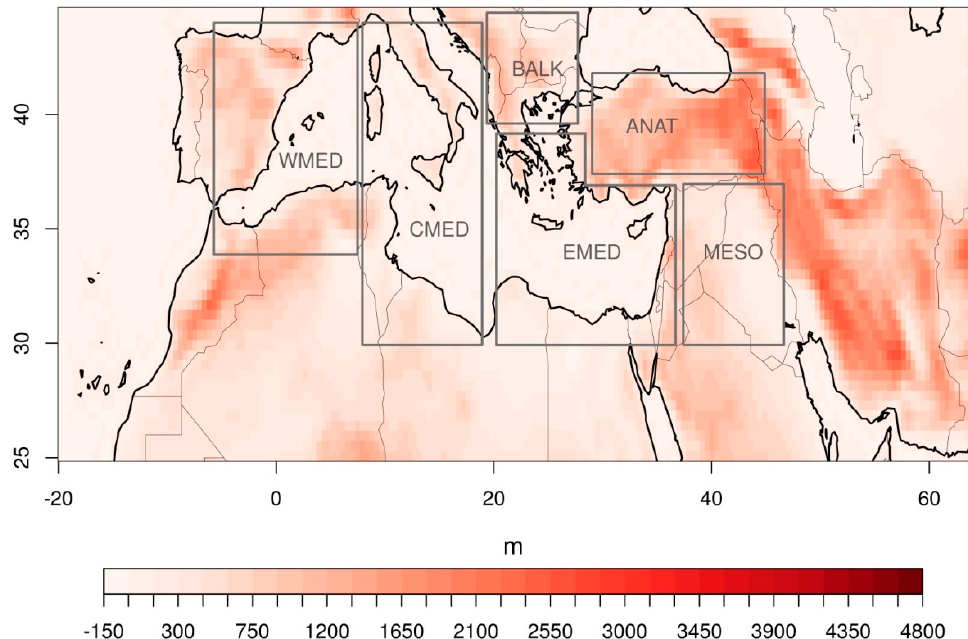
Figure 1. Orography of the MENA domain used in the analysis, with the 6 sub-regions (Anatolia, Balkans, western, central & eastern Mediterranean and Mesopotamia).